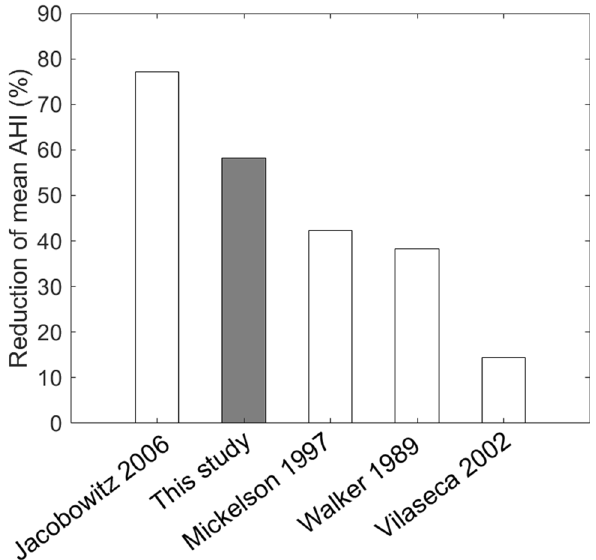
Figure 8. Comparison of surgical outcome in similar studies. See text for